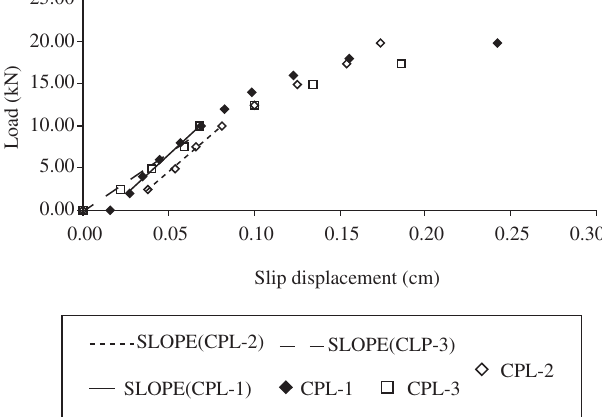
Figure 8. Experimental longitudinal load vs. measured displacement diagram, for specimens CPL-1, CPL-2 and